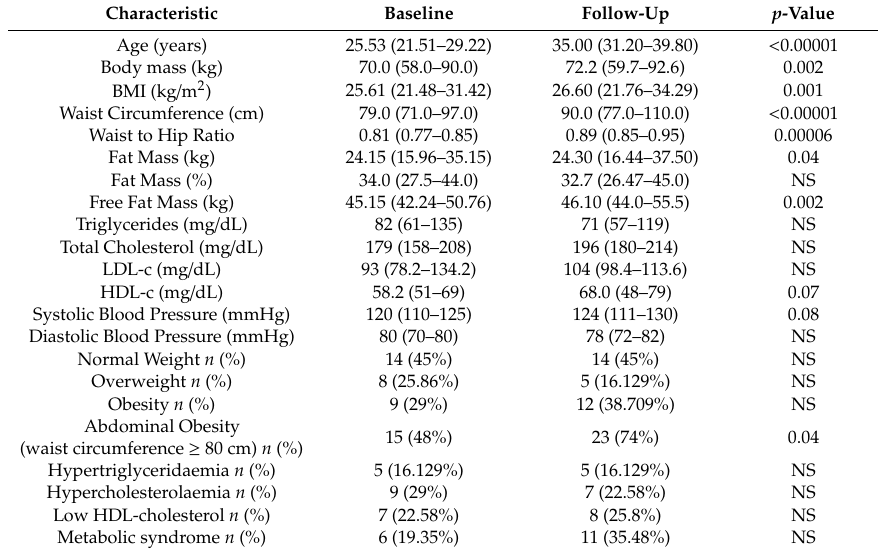
Table 1. Characteristics of the participants at the beginning and at the end of follow-up ( n = 31). Characteristic